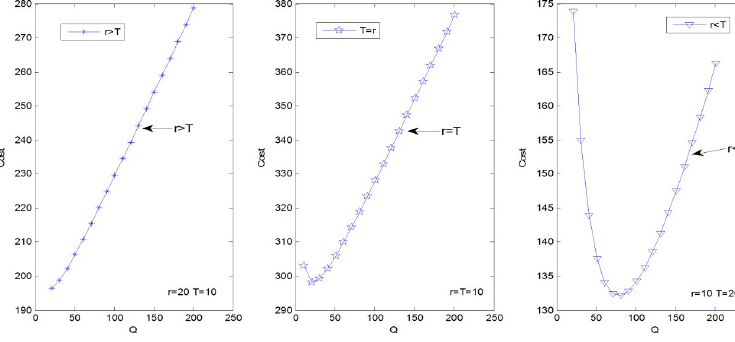
Fig 6. The inventory cost as a function of Q .